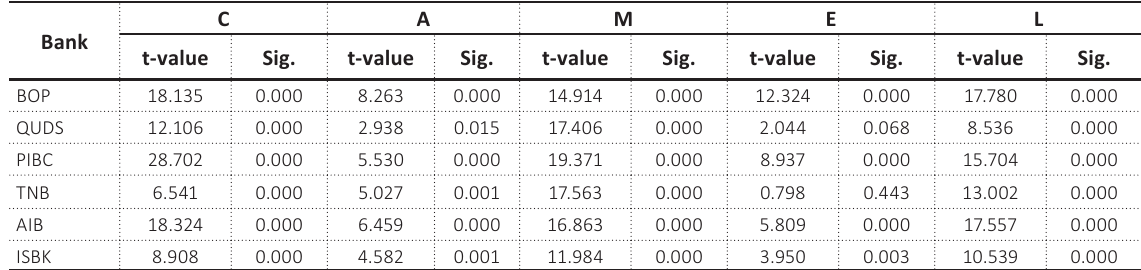
Table 11. The results of one sample